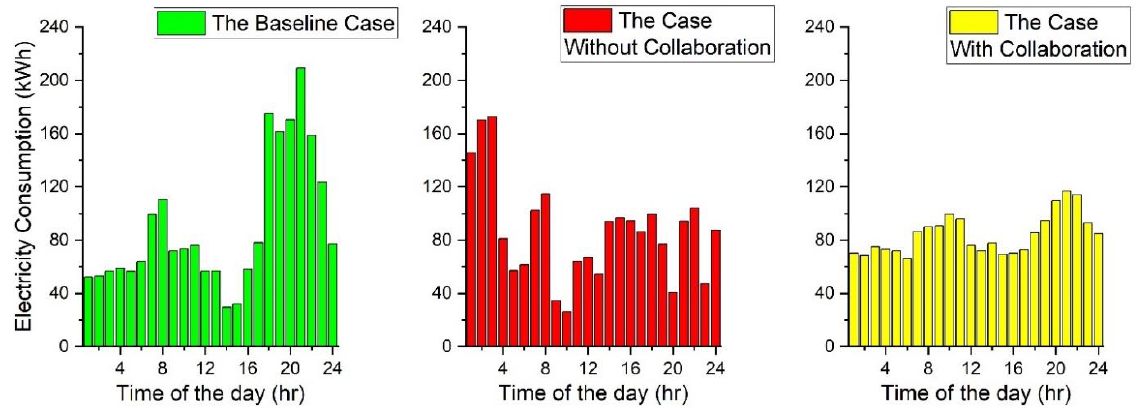
Figure 9. The comparison of total electricity demand for a small-scale building community.